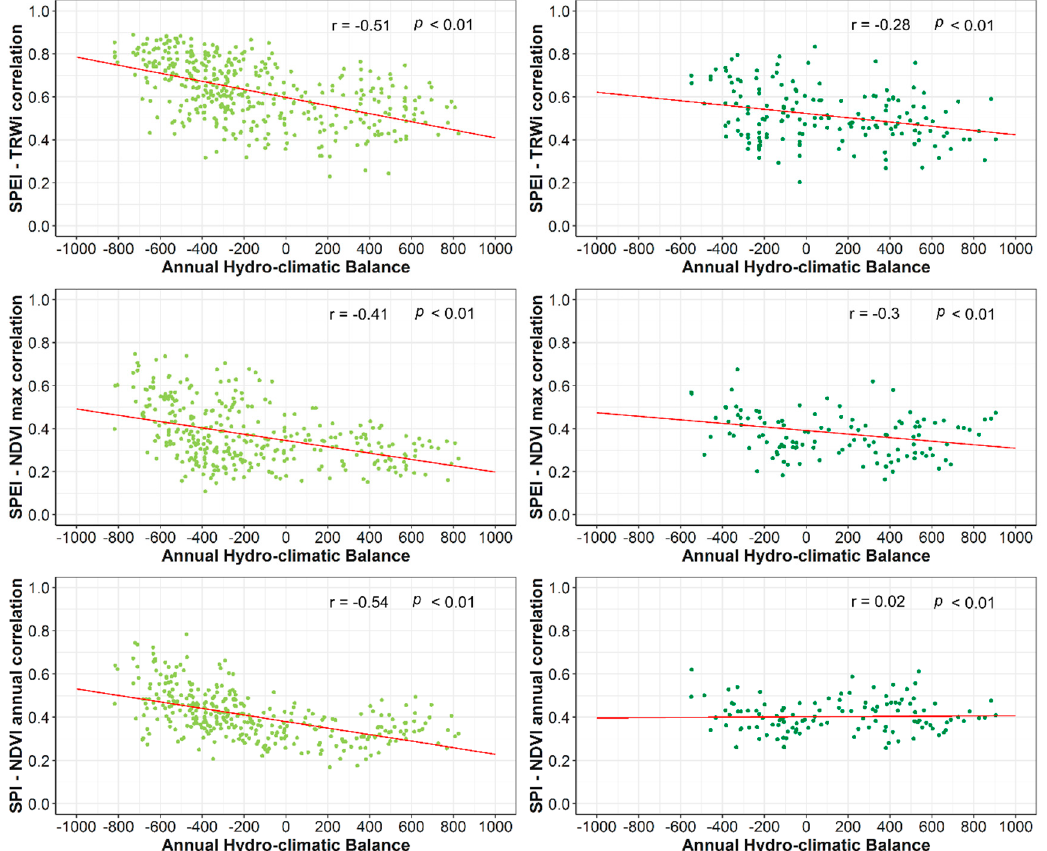
Figure 7. Scatter plots showing the relationship between maximum Pearson correlations found for SPEI-TRWi, SPEI-NDVImax, SPI-NDVIannual, and the average annual water balance of hardwood species ( right , dark green) and conifers ( left , light green). Solid red line corresponds to the fitted lines of regression models.